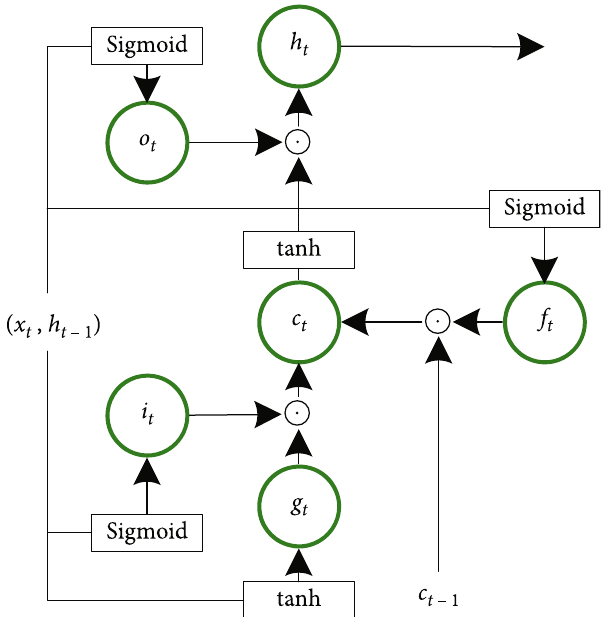
Figure 1: The diagram of LSTM unit